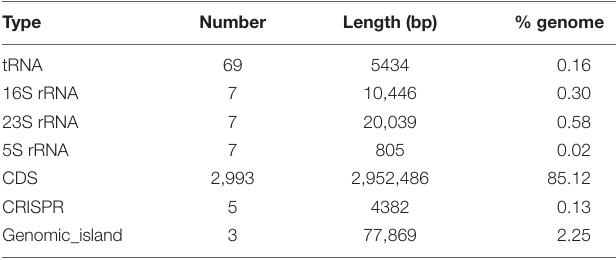
TABLE 1 | Statistics for genomic structure prediction of S. dextrinosolvens